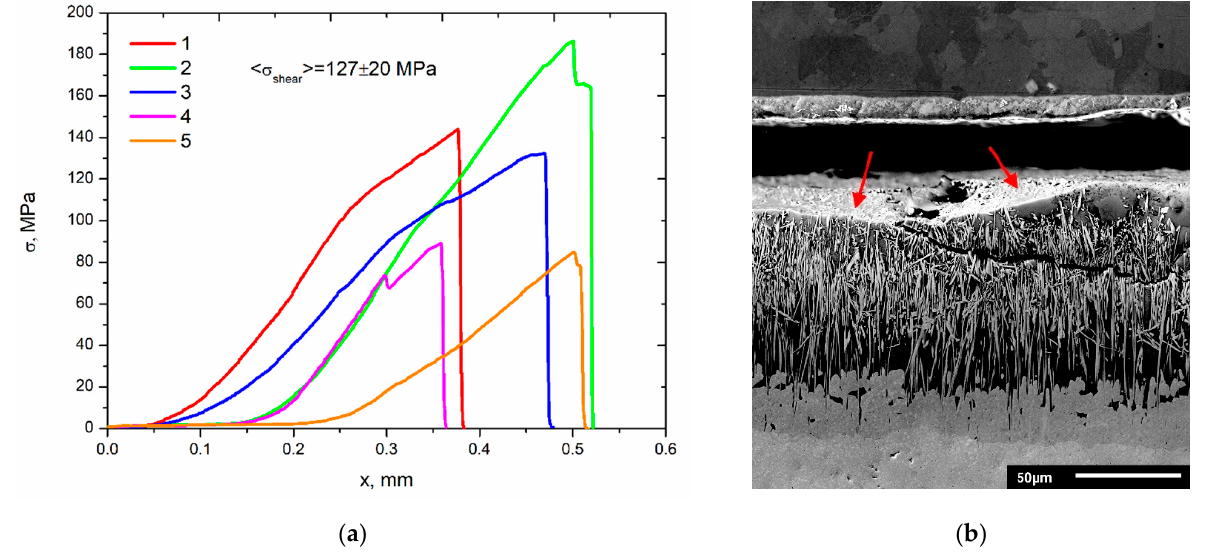
Figure 10. The results of shear strength test: ( a ) stress—displacement curves: ( b ) Rusfer/ TiZr4Be/Ta failure zone (secondary electrons).